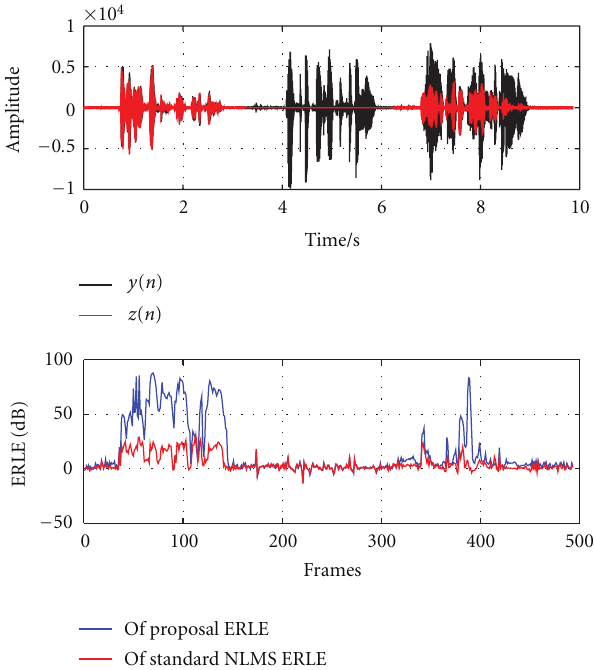
Figure 3: Typical ERLE evolution, AMR 12.2 kbps to 7.4 kbps. proposal, and no audible distortion is noticed. In double talk periods, the e ff ect of our method is noticeable. In average, the ERLE is 8 dB and 15 dB in transcoding from AMR 12.2 to 7.4 and AMR 7.4 to 12.2, respectively. The standard NLMS achieves an average of 3 dB and 1.3 dB in transcoding from AMR 12.2 to 7.4 and AMR 7.4 to 12.2, respectively. These measures reveal that our proposal can impact the acoustic echo during double talk